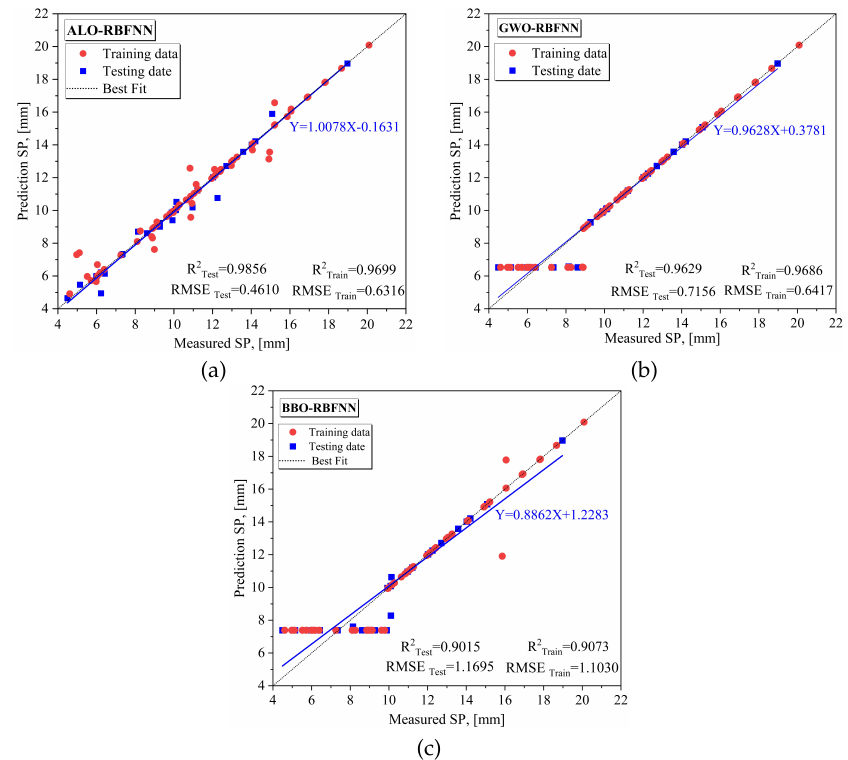
Fig. 8. Scatter plot of measured and predicted the pile settlement using: a) ALO-RBFNN; b) GWO-RBFNN; c) BBO-RBFNN